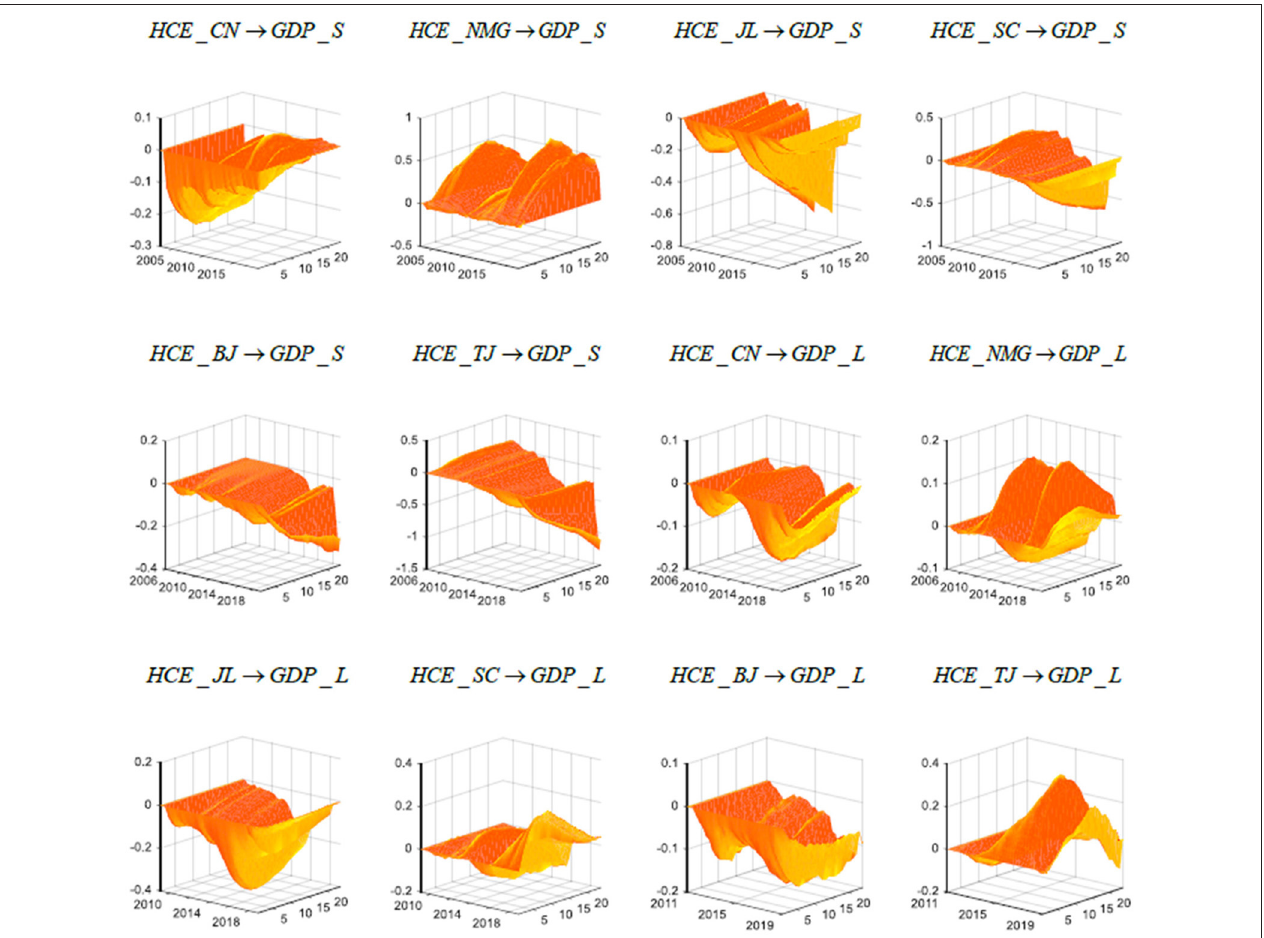
FIGURE 3 | Robustness test results: change in the selection of the variable lag order. The results shown in the figure are for the second-order lag. Due to space limitations, the empirical results of the remaining lagged orders are not listed individually but maintained for reference. Each subfigure with the title of “ X → Y ” demonstrates the response of variable Y to an orthogonalized positive shock to variable X. In other words, X is an impulse variable, and Y is a response variable. One period in the figure denotes one